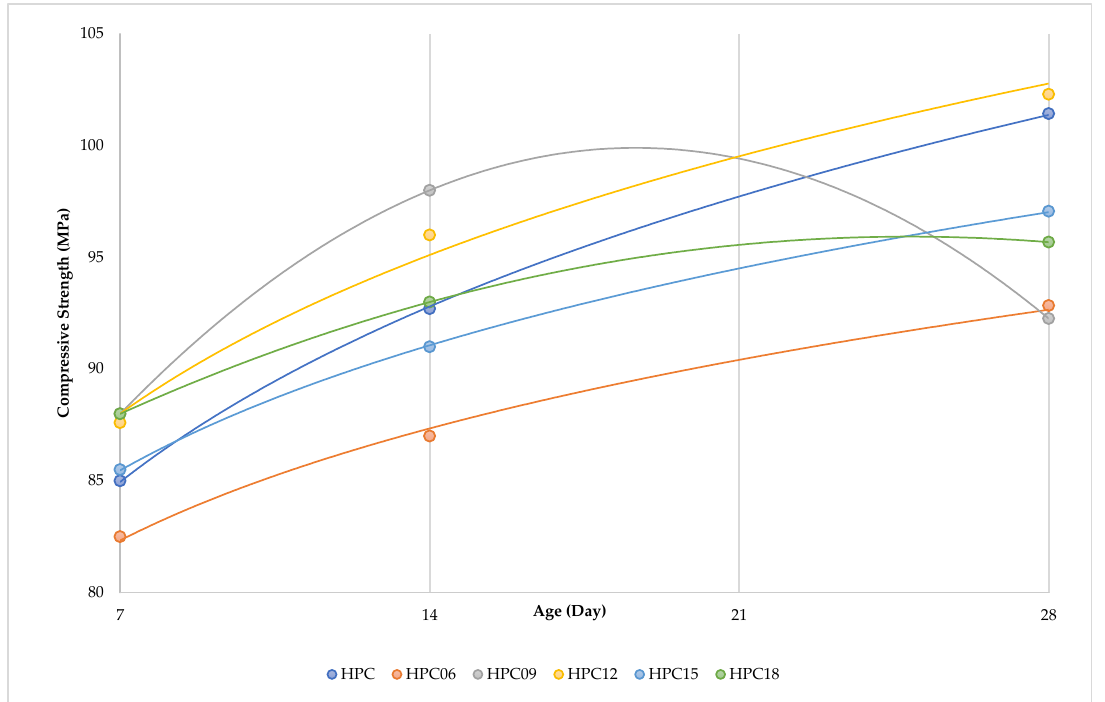
Figure 12. Compressive Strength Workability in Different Curing Periods.